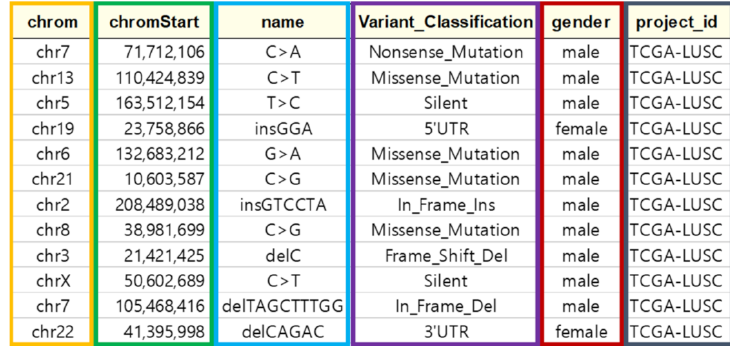
Figure 8. Variable information to be used as training data.